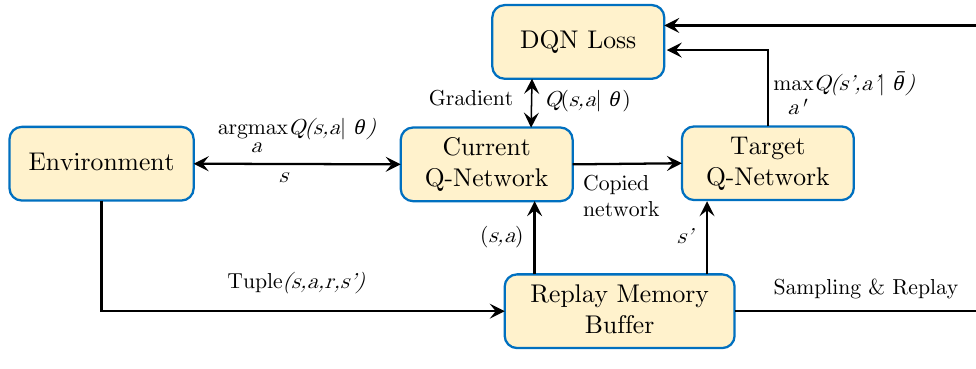
Figure 3. DQN learning